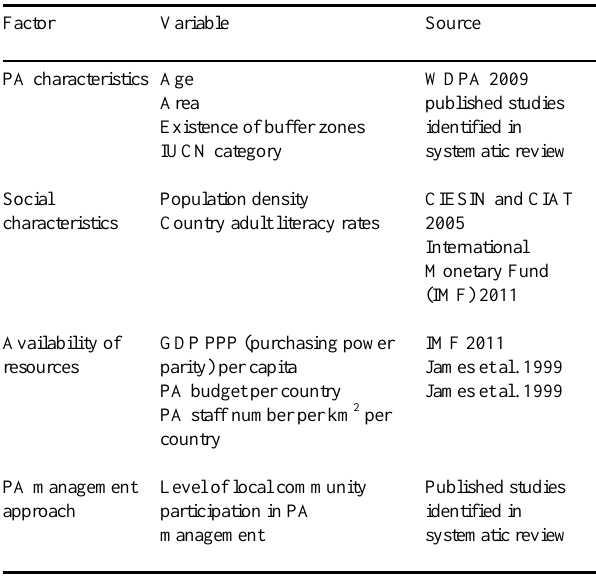
Table 1. Variables hypothesized to influence compliance with protected area (PA) policies and categorized into four key types of